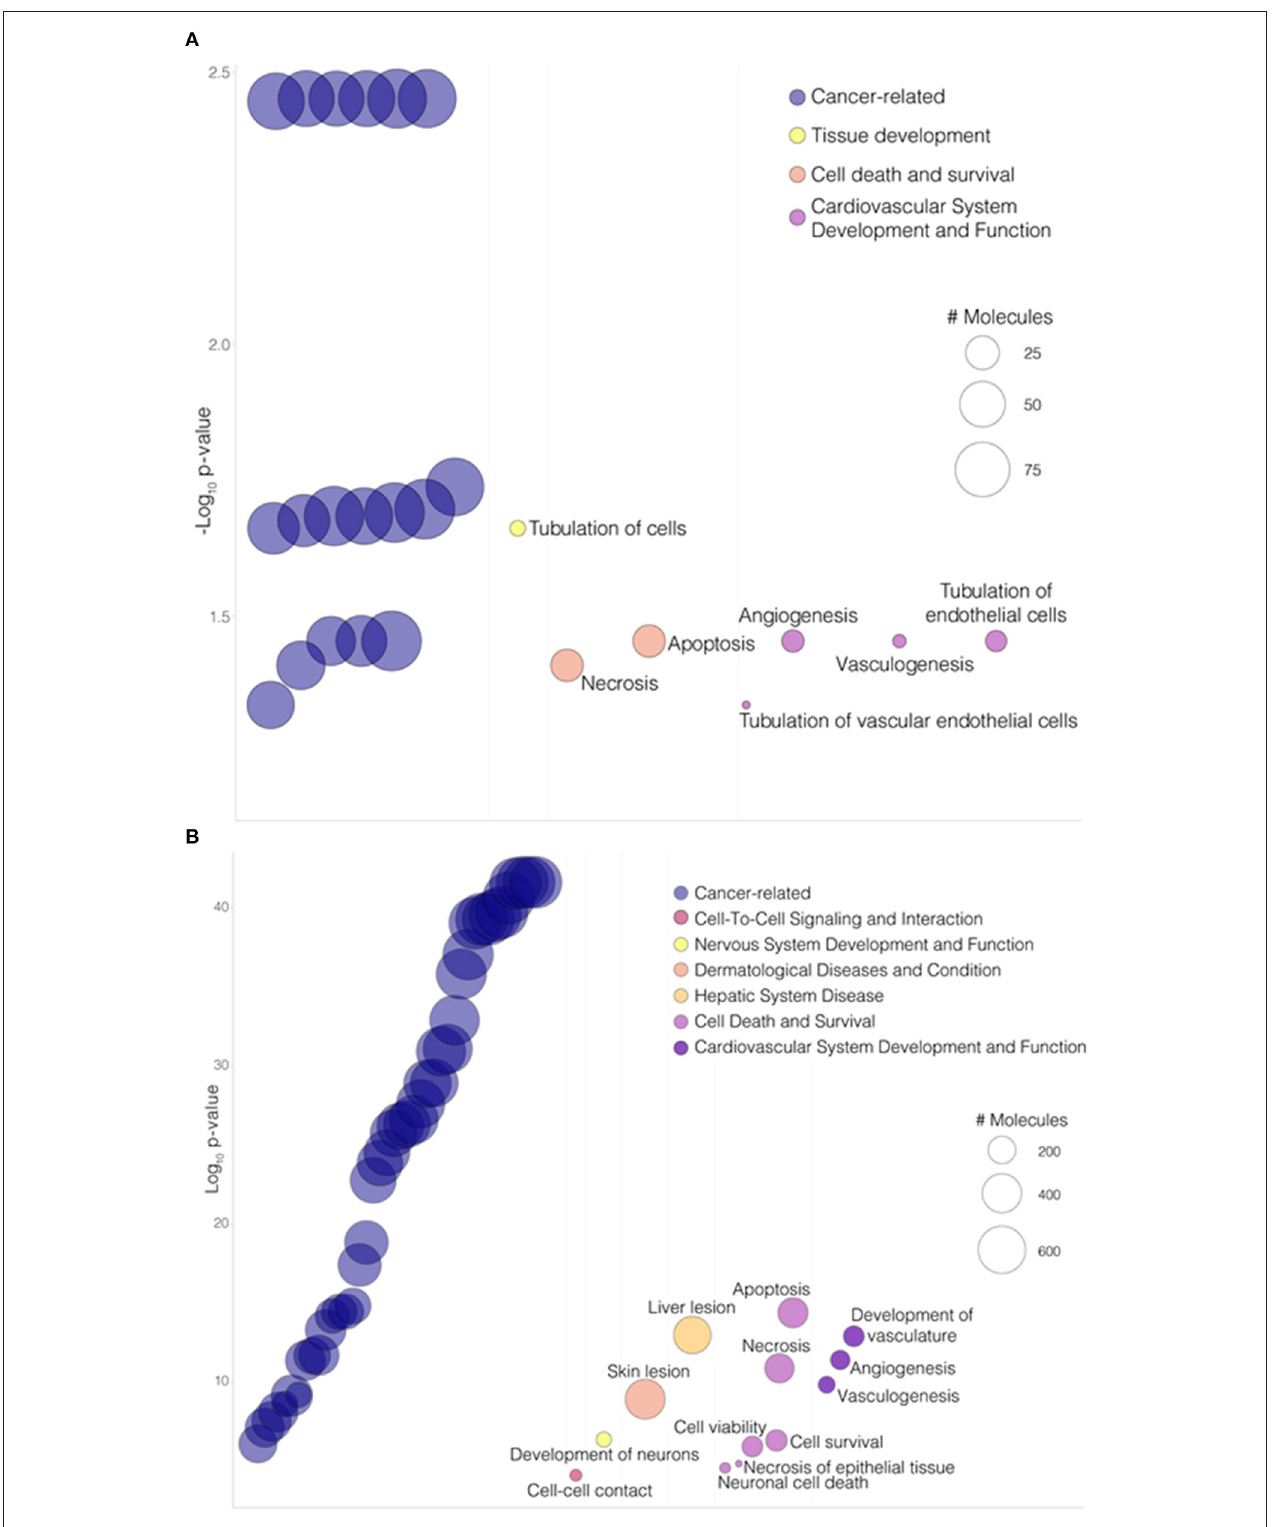
FIGURE 8 | AMIGO2 associated functions. (A) Bubbleplot portraying a selection of “Diseases and Biological Functions” enriched pathways involving AMIGO2 from IPA analysis, in the 24 h dyn vs. 24h stat comparison. (B) Bubbleplot portraying a selection of “Diseases and Biological Functions” enriched pathways involving AMIGO2 from IPA analysis, in the 72 h dyn vs. 72h stat comparison. Pathways are organized by macro-categories on the x-axis and ordered by -log 10 BH-adjusted p -value on the y-axis. The bubble size is proportional to the number of molecules involved in the pathway.